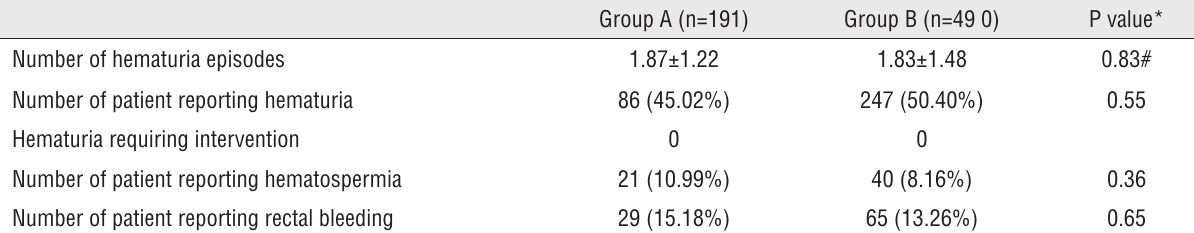
Table 2 - post-biopsy complications.